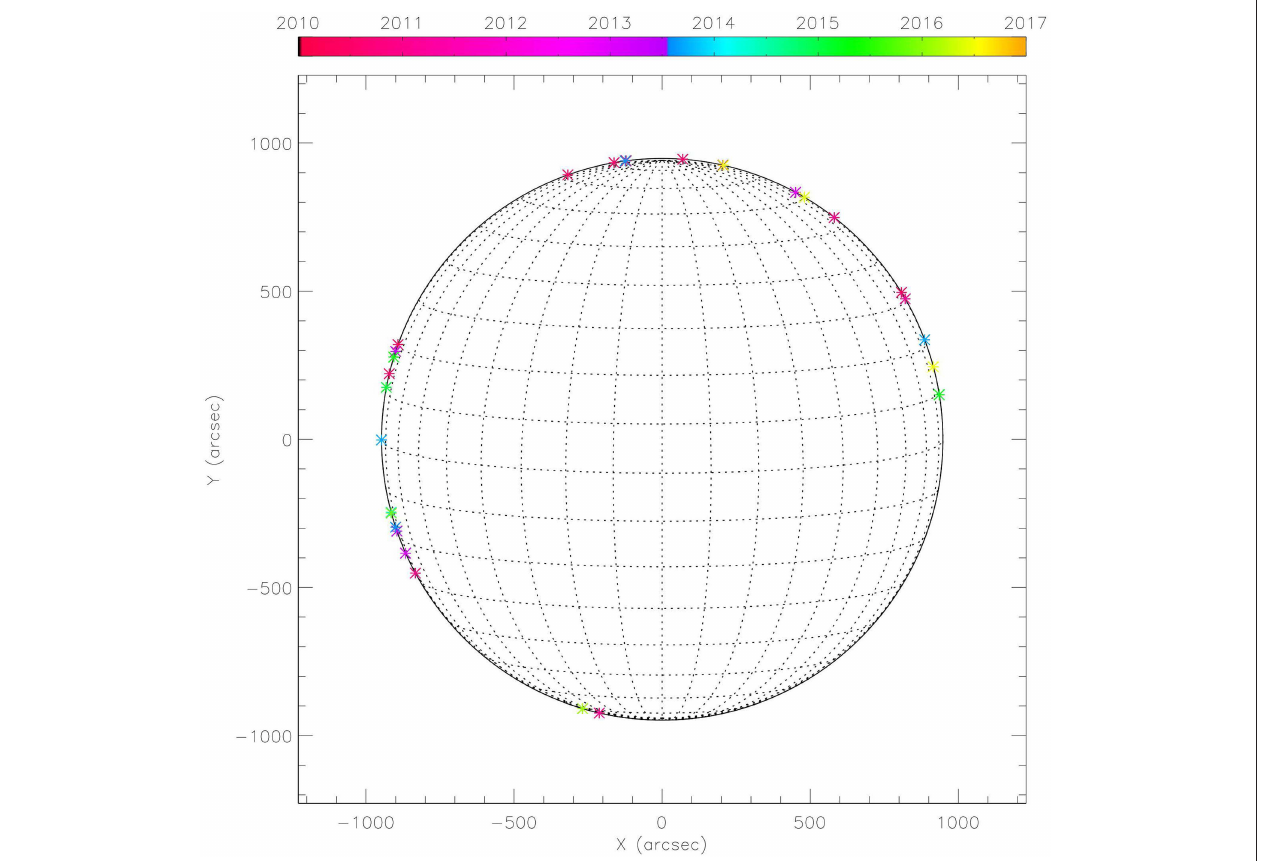
FIGURE 1 | Location of the apparent source regions on the solar limb of all the studied 30 rotational coronal jets from 2010 to 2017. Colors denote dates of